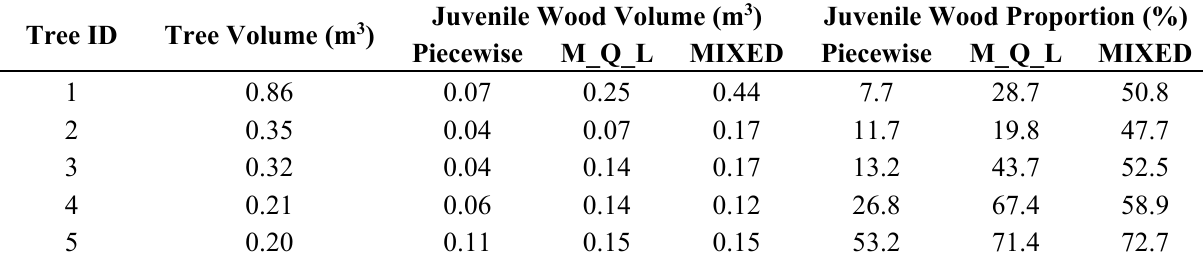
Table 7. Tree volume, juvenile wood volume, and juvenile wood proportion from 1.3 to 13.3 m obtained from five trees using the piecewise, maximum-quadratic-linear (M_Q_L), and MIXED